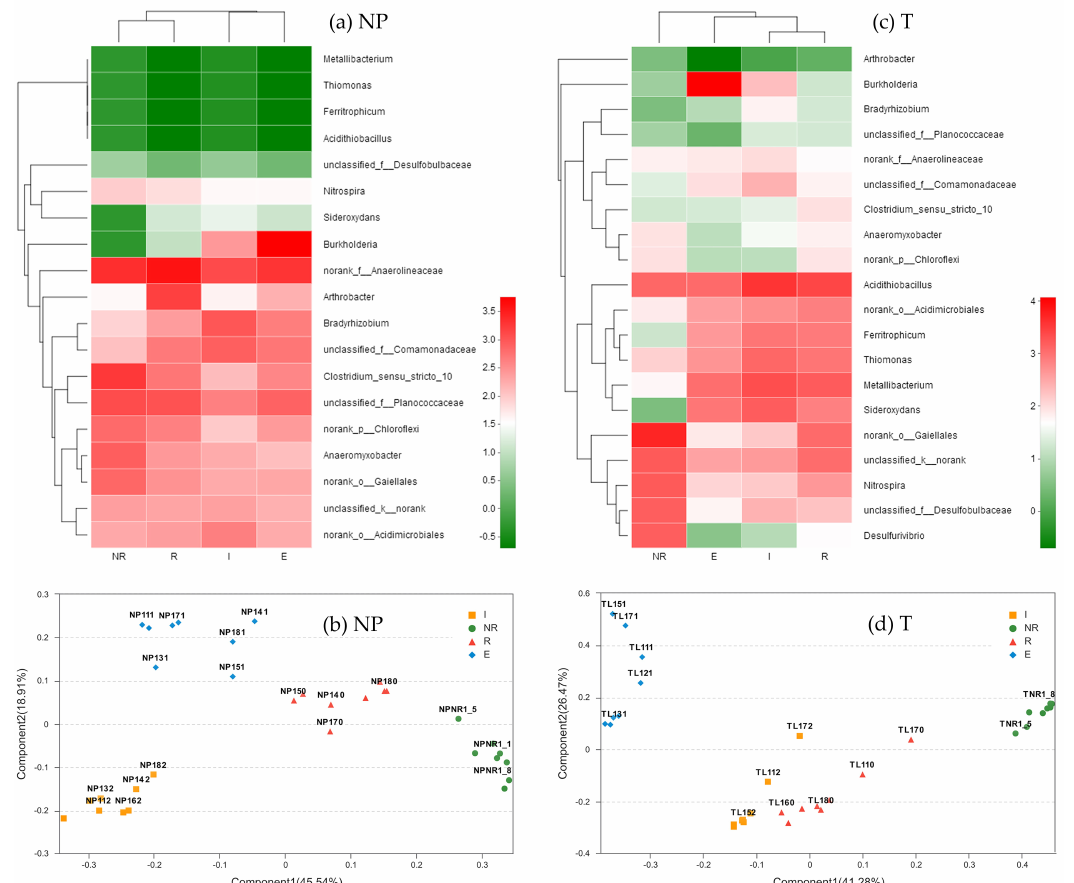
Figure 5. The heatmap analysis of bacteria at the genus level in the non-rhizosphere (NR), rhizosphere (R), external layer of iron plaque (E) and internal layer of iron plaque (I) in ( a ) the non-polluted soil (NP) and ( c ) the tailing soil (T). The heatmap plot depicts the relative percentage of each bacterial taxon (variables clustering on the Y-axis) within each sample (X-axis clustering). The relative values for the bacterial taxa are represented by color intensity according to the legend. The PCoA analyses of bacteria at the genus level in the NR, R, E and I zones in ( b ) the NP and ( d ) the T. The percentages of the diversity distributions explained by each axis is indicated on the figure. Samples associated with the I (yellow squares), NR (green circles), R (red triangles) and E (blue rhombuses) zones are shown as single